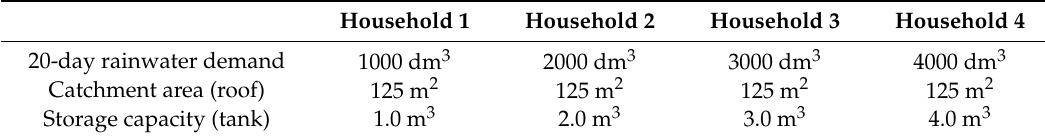
Table 1. Determining factors of four analysed cases of residential RWH system.